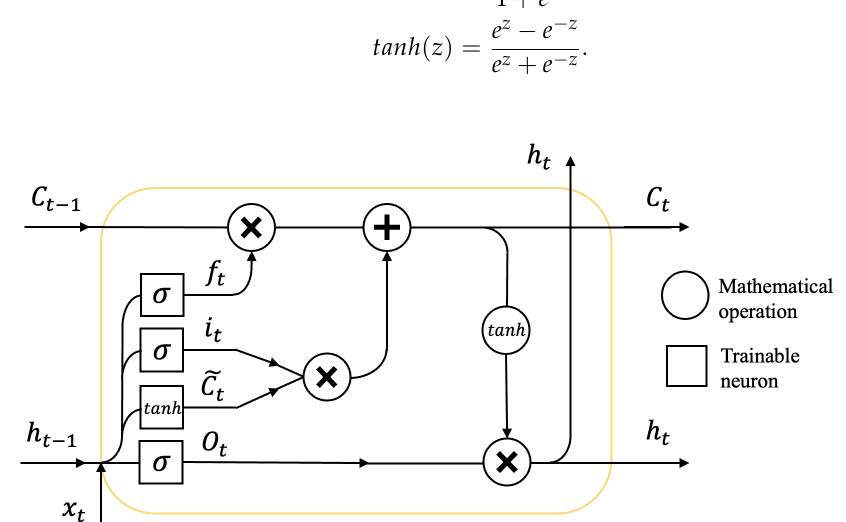
Figure 2. A schematic of the inner workings of an LSTM memory